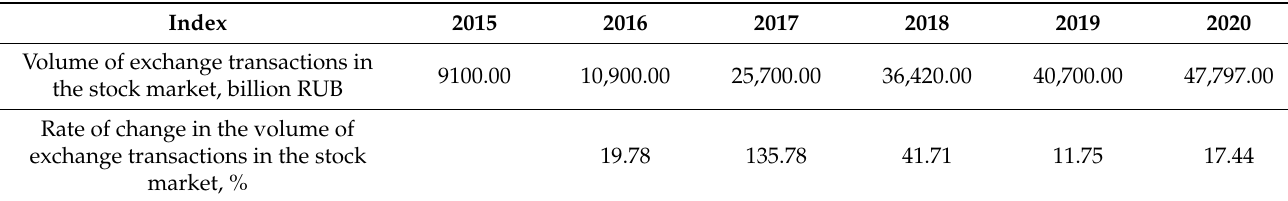
Table 3. Dynamics of exchange transactions in the Russian Federation, billion